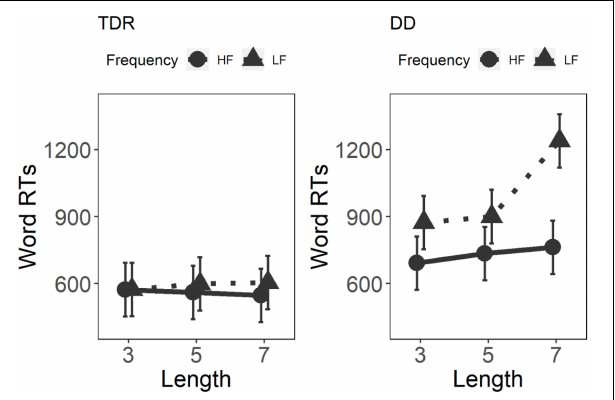
FIGURE 1 | Three-way interaction on the speed on Words. TDR, typical developing readers; DD, developmental dyslexics; HF, high frequency; LF, low frequency; and RTs, reaction